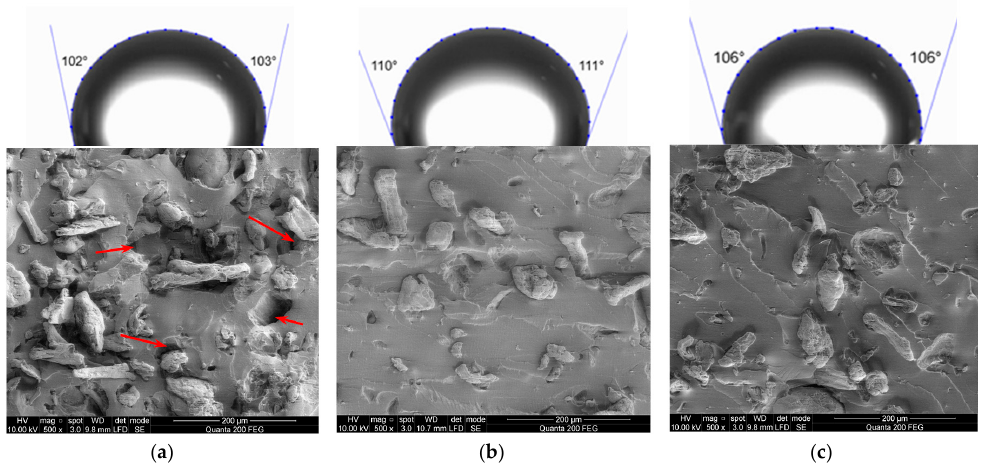
Figure 13. SEM images of fractured surfaces of tensile samples of PDMS/CF (10 wt.%) composites and water droplets on their surface at the loading of ( a ) CF, ( b ) CFvap, and ( c ) CFliq (silylation time 6 h). The influence of cellulose microfiber silylation on the water vapor behavior of PDMS/CF